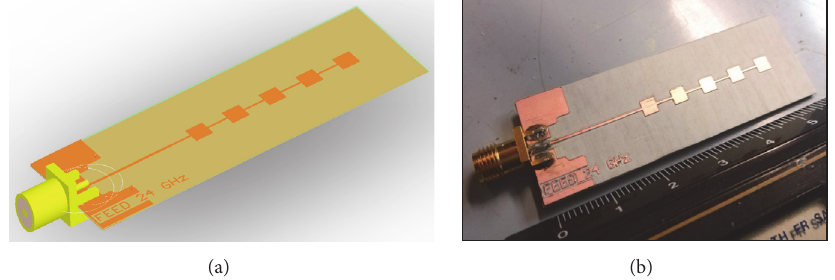
Figure 8: Model of the 24 GHz coaxial-to-microstrip transition (a) and realized structure (b).